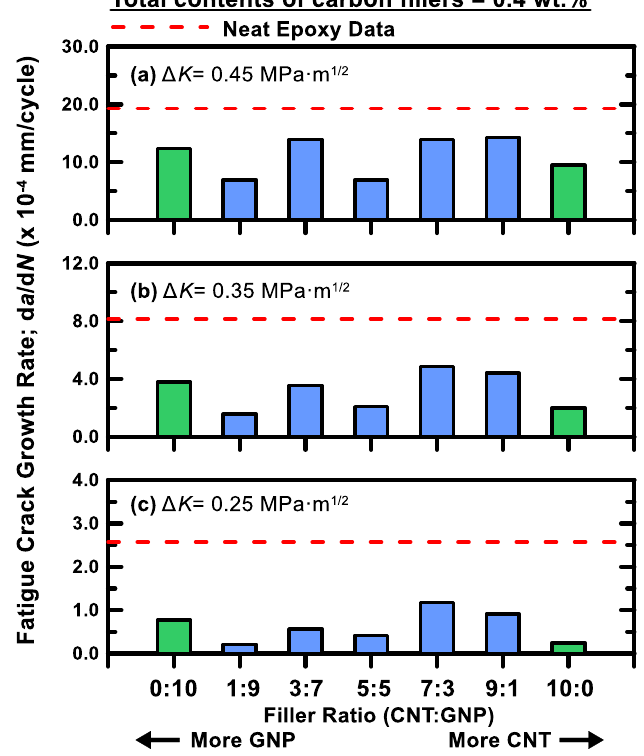
Figure 14. Comparison between the crack propagation rates of the nanocomposites with various filler ratios at Δ K = ( a ) 0.45; ( b ) 0.35; ( c ) 0.25 MPa • m 1/2 .